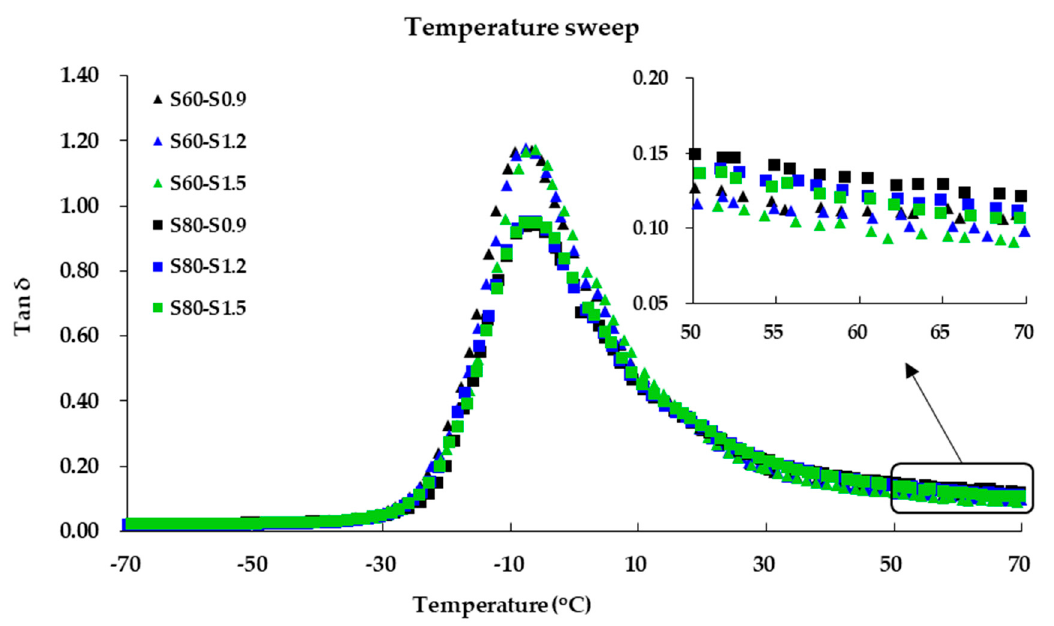
Figure 3. Tan δ curves measured at the temperature sweep condition.